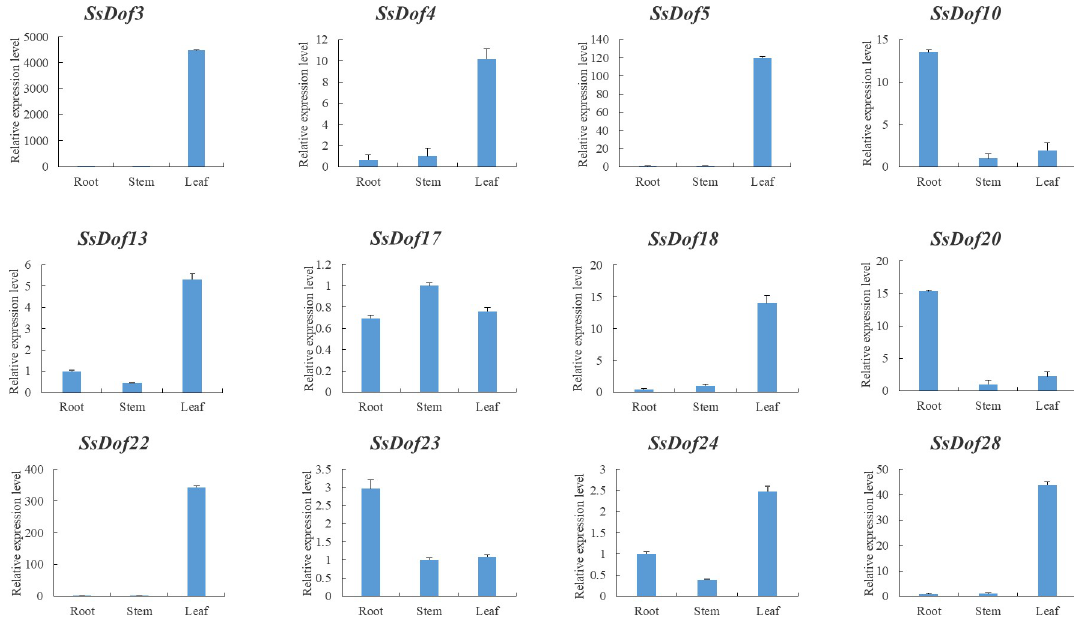
Fig 7. Expression levels of SsDof genes at the seedling stage by qRT-PCR. The tissue samples were obtained from root, stem and leaf in seedling stage (45 days old). The standard deviation was indicated with the vertical bars.